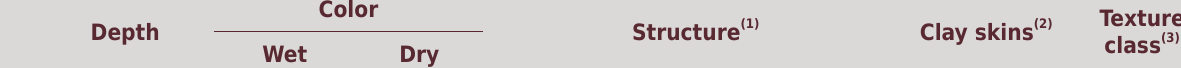
Structure (1) Clay skins (2)